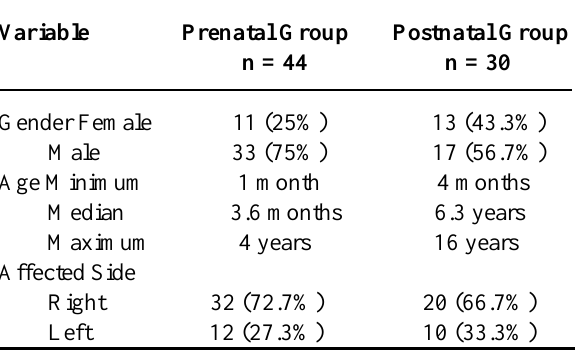
Table 1 – General clinical characteristics of the patients.